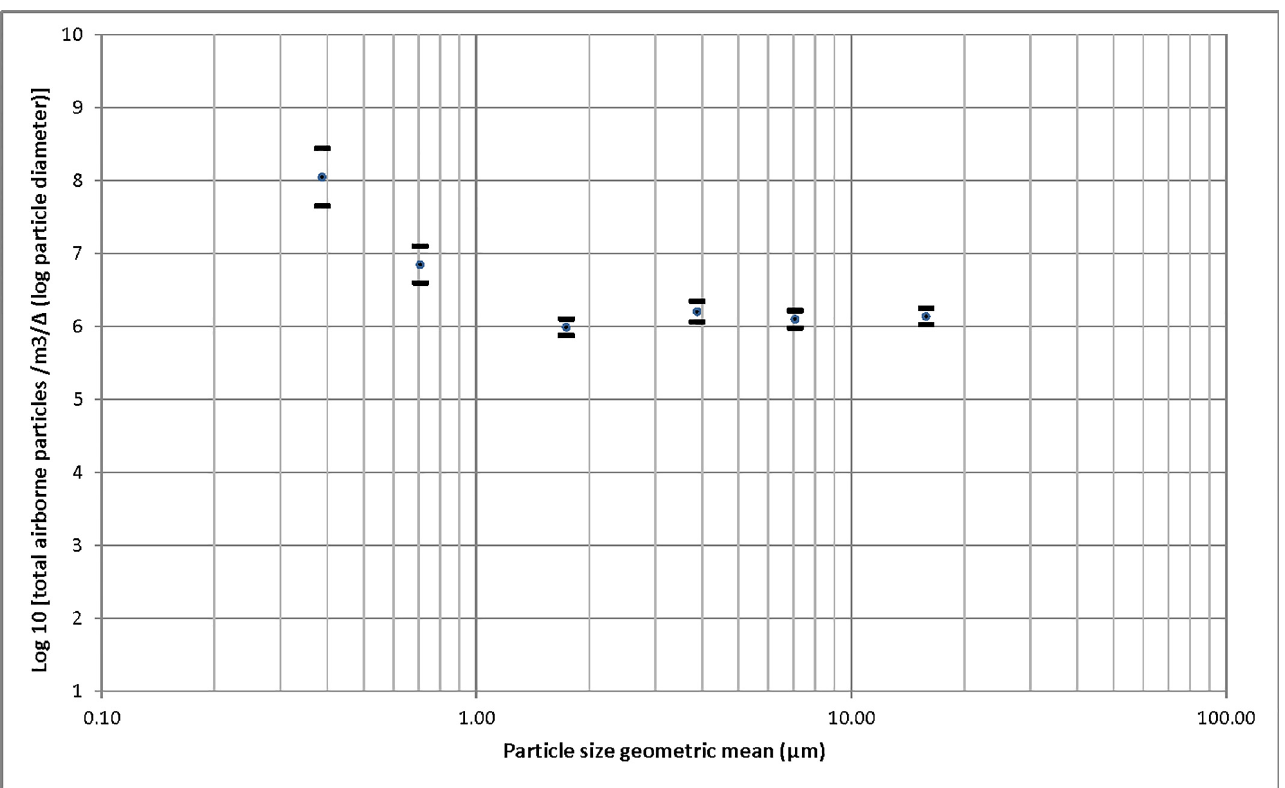
Fig 3. Total airborne particles distribution. Distribution of total airborne particles (geometric mean of number of particles/m 3 and 95% confident interval) measured using an optical particle counter.